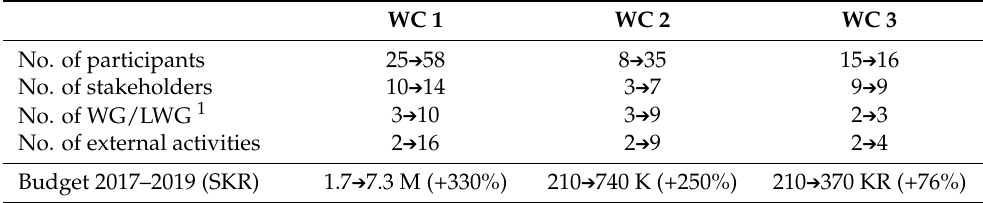
Table 6. Development of the cases during the WaterCoG project due to the project